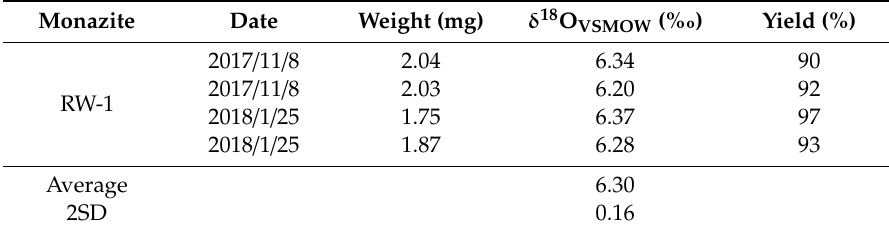
Table 3. Results of LF-IRMS determinations of RW-1 δ 18 O